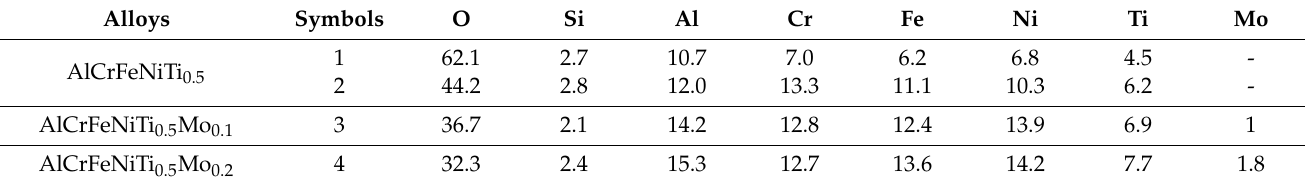
Table 4. Chemical compositions (at. %) of different regions in worn surfaces of AlCrFeNiTi 0.5 ,